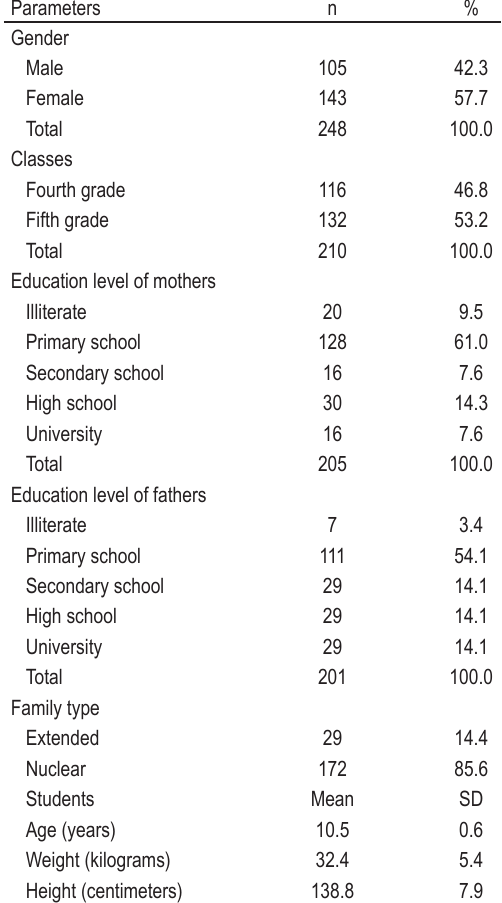
TABLE 1. Socio-demographic characteristics of the